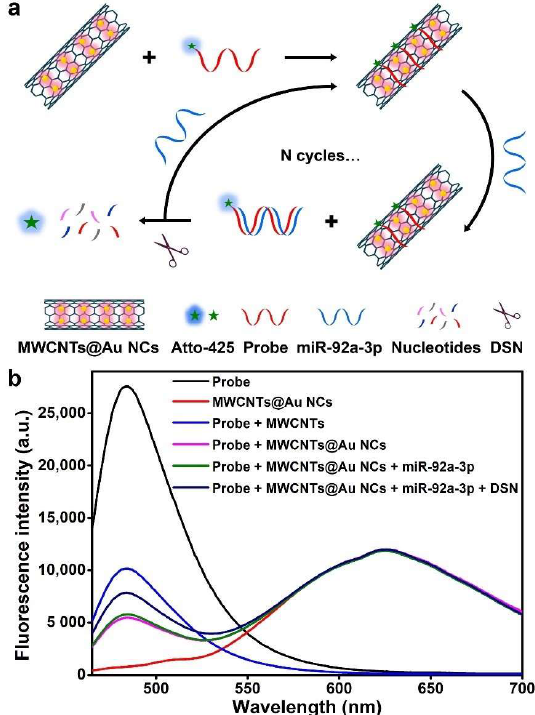
Figure 3. ( a ) Schematic diagram of fluorescence detection of miR-92a-3p based on MWCNTs@Au NCs and DSN-assisted signal amplification. ( b ) Fluorescence spectra of probe, MWCNTs@Au NCs, probe + MWCNTs, probe + MWCNTs@Au NCs, probe + MWCNTs@Au NCs + miR-92a-3p, and probe + MWCNTs@Au NCs + miR-92a-3p + DSN.